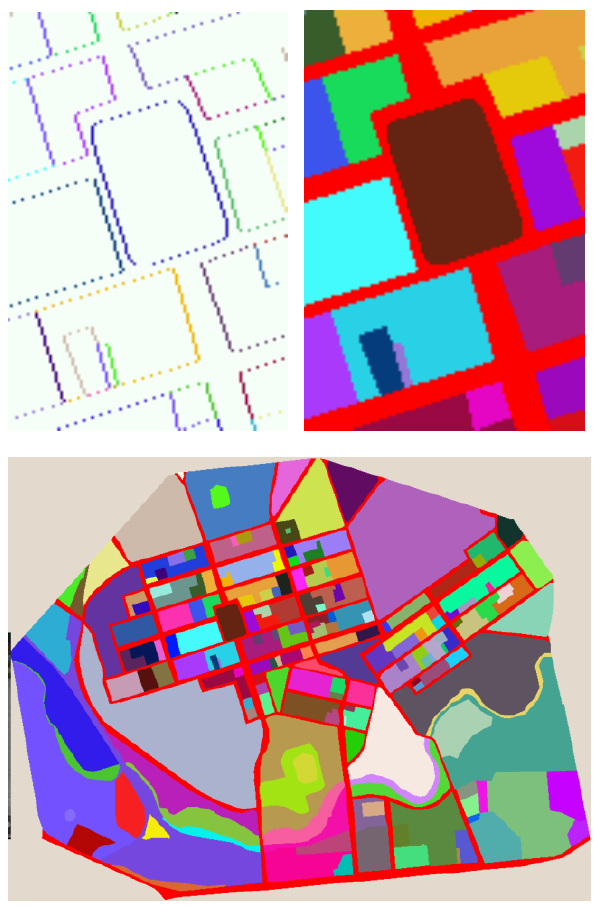
Fig. 9 Historical land use map of the City centre of Adelaide (AUS) (below), with a detail (upper right) and its preceding sparse boundary grid (upper